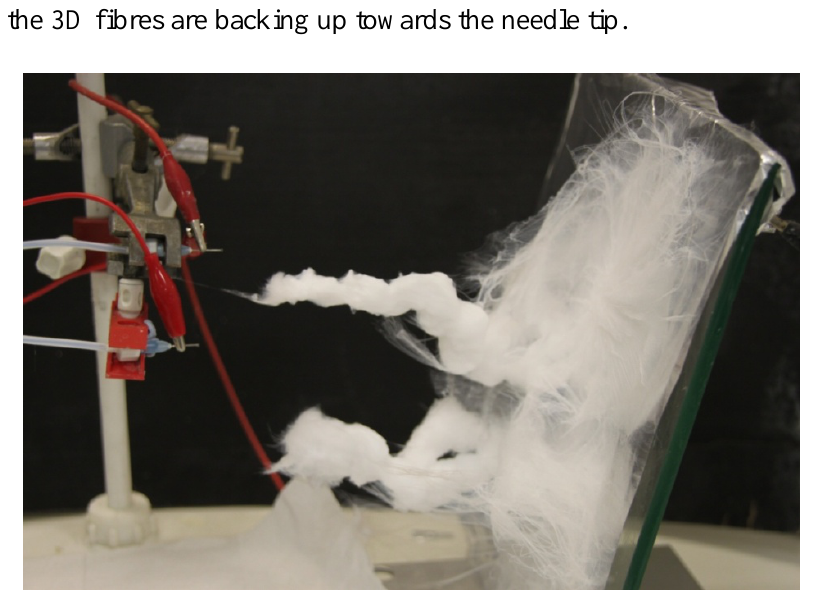
Figure 4. Image of the collection of 3D fibres using solution 13 and a double needle setup. Notice how the 3D fibres are backing up towards the needle